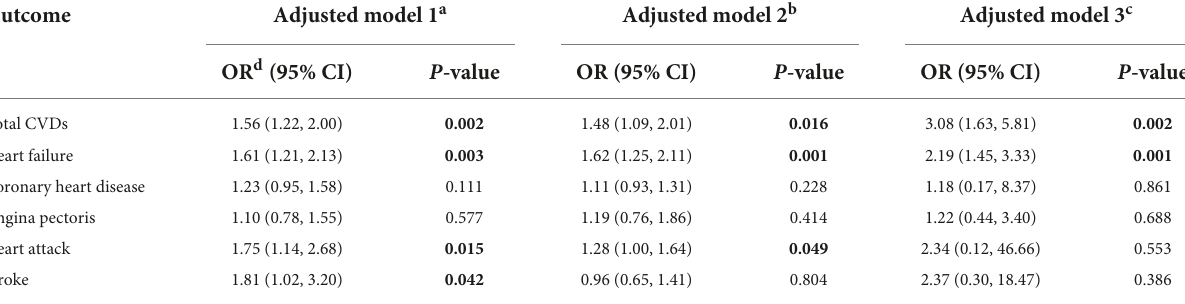
TABLE 3 Associations between MMA (ln nmol/L) and CVDs by multivariable logistic regression